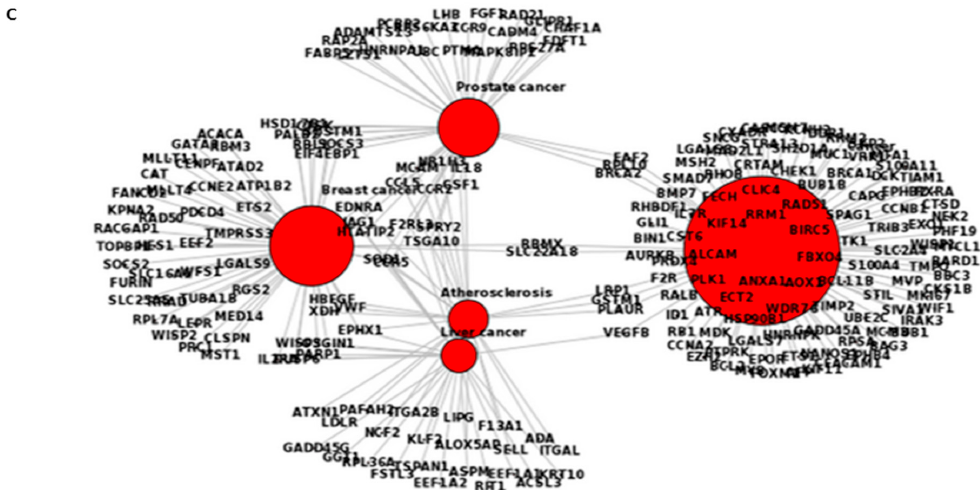
Figure 7. Ontology of common altered genes between the treated BS-24-1 cells and the ENSEMBLE human genome database using BioMart online software. ( A ) Genes related to pathways in the mouse genome. ( B ) genes related to pathways in human genome. Blue circles represent the main intercellular mechanisms while the green circles represent genes whose expression was altered by A. graveolens extract. ( C ) DO-terms related to cancer-enriched genes altered by A. graveolens extract using FunDO software. Red circles represent parent (large circle on the right) and child DO-terms related to cancer.